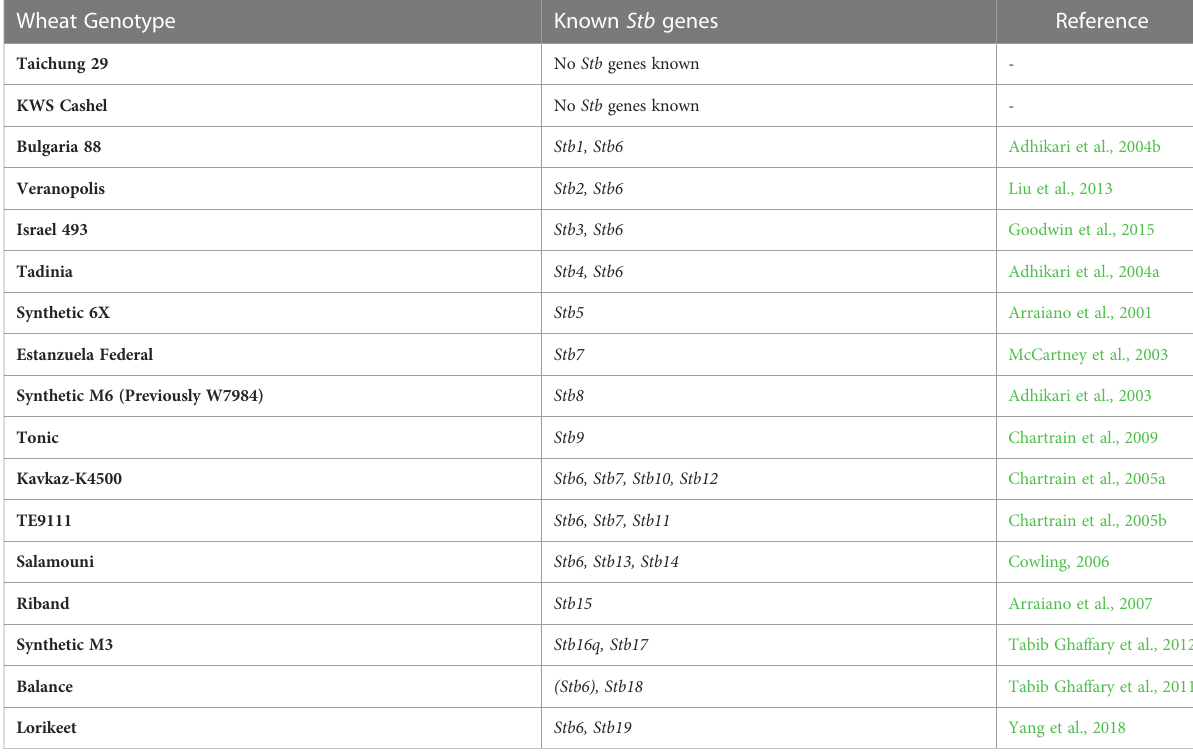
TABLE 1 Wheat lines used in this study with known Stb